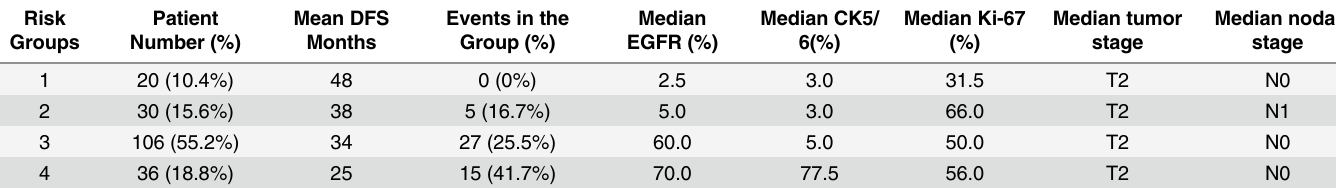
Table 3. TNBC patient risk groups stratified by EGFR, CK5/6, Ki-67, pT and pN. Risk Patient Groups Number